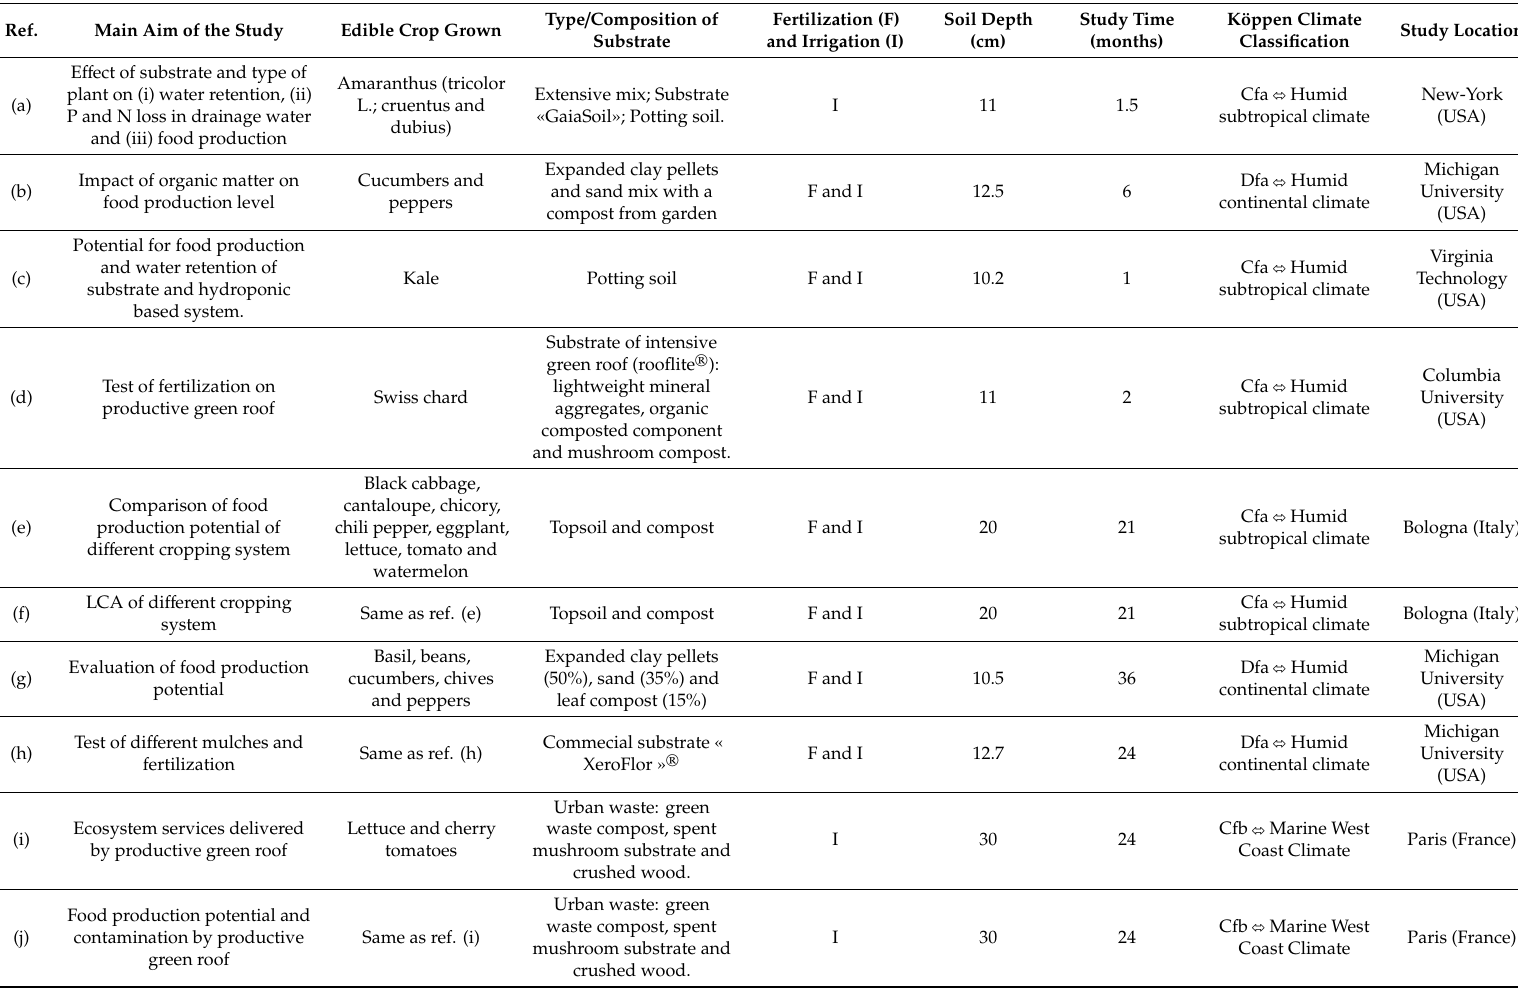
Expanded clay pellets and Cucumbers and peppers sand mix with a compost from Substrate of intensive green roof (rooflite ® ): lightweight Swiss chard mineral aggregates, organic composted component and mushroom